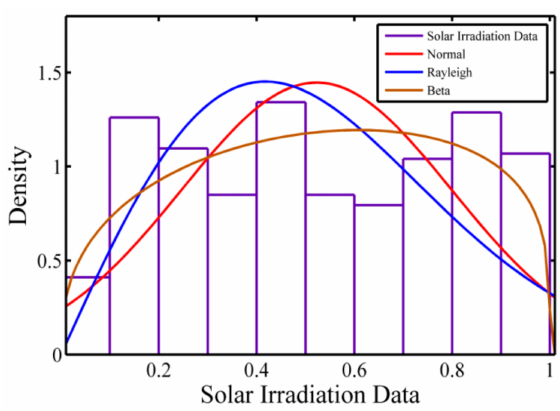
Figure 2. Past solar irradiance data fitting. Table 2. Past solar data fitting results for different pdfs. Normal